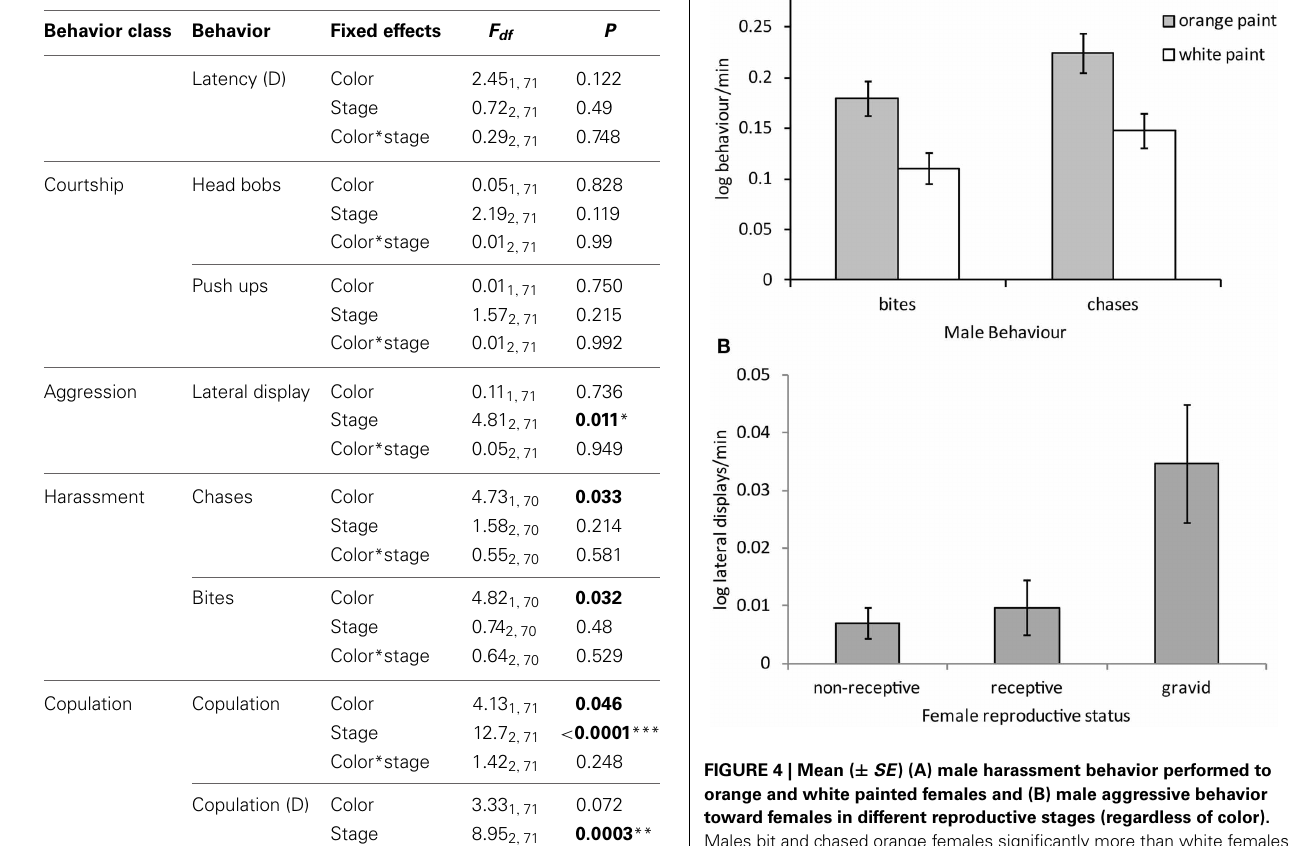
Table 3 | The effects of color, female reproductive stage and their interaction on the behaviors of male lizards.